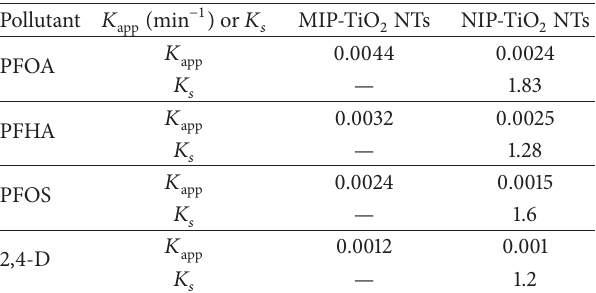
Table 4: Apparent rate constant 𝐾 catalytic degradation in single-solute